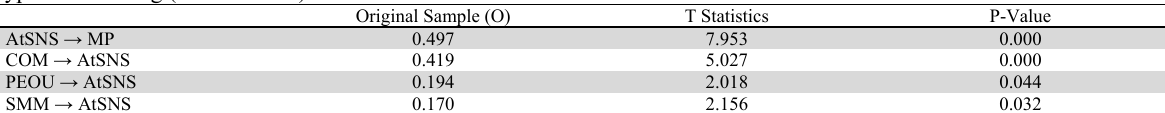
hypothesis testing (Direct